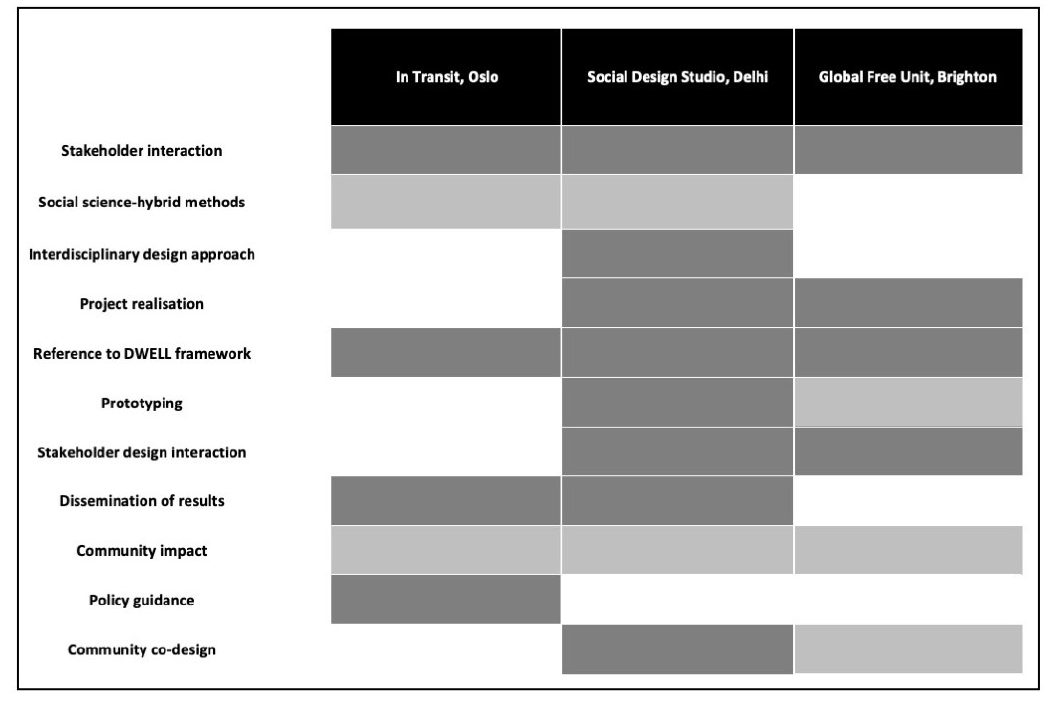
Figure 4. Placemaking transactionally across the studios (Source: Peter